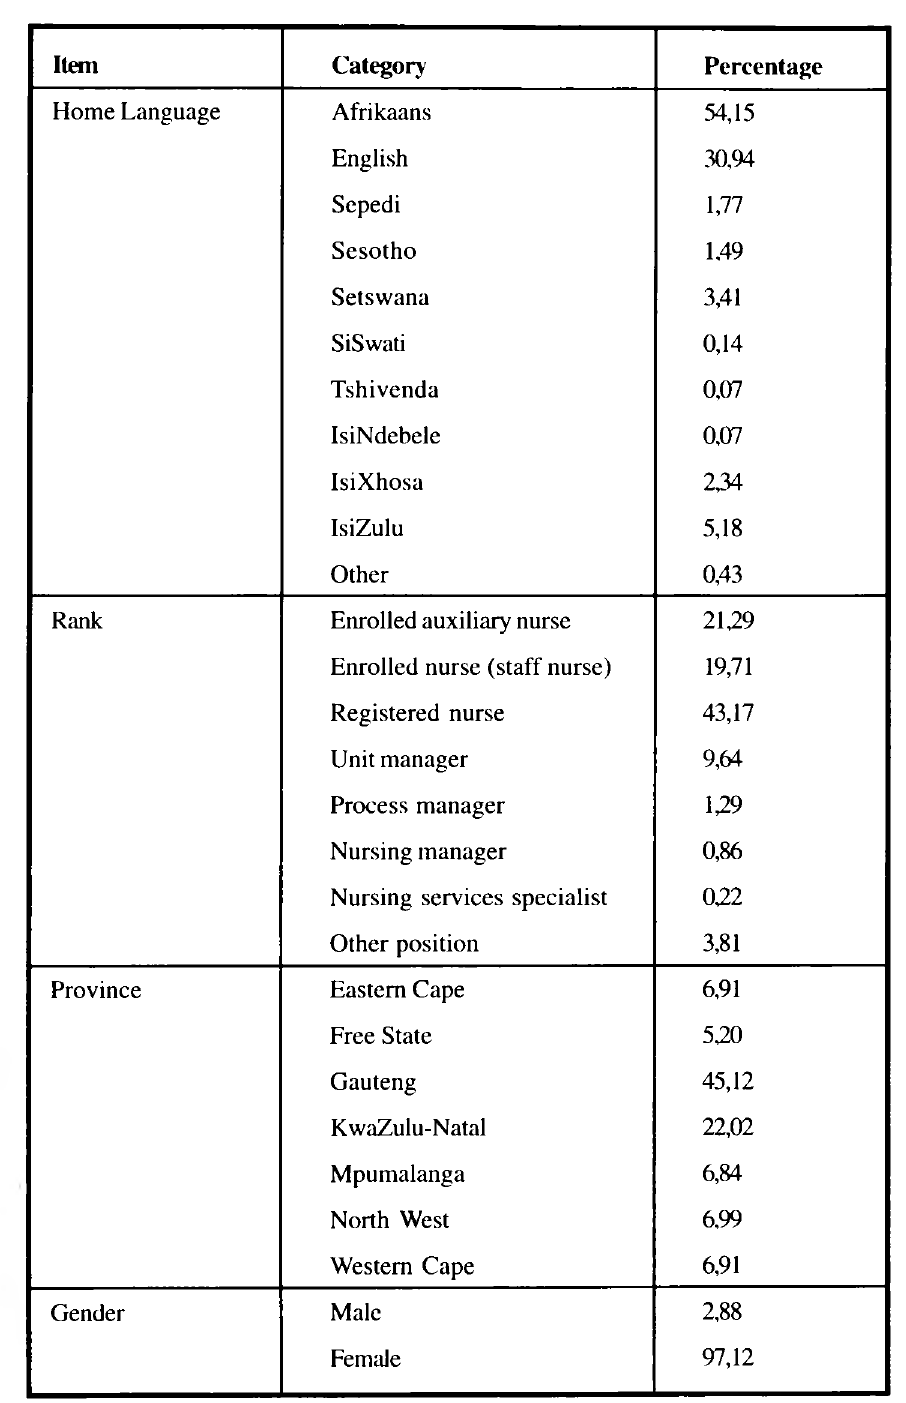
Table 1 Characteristics of the participants (n =